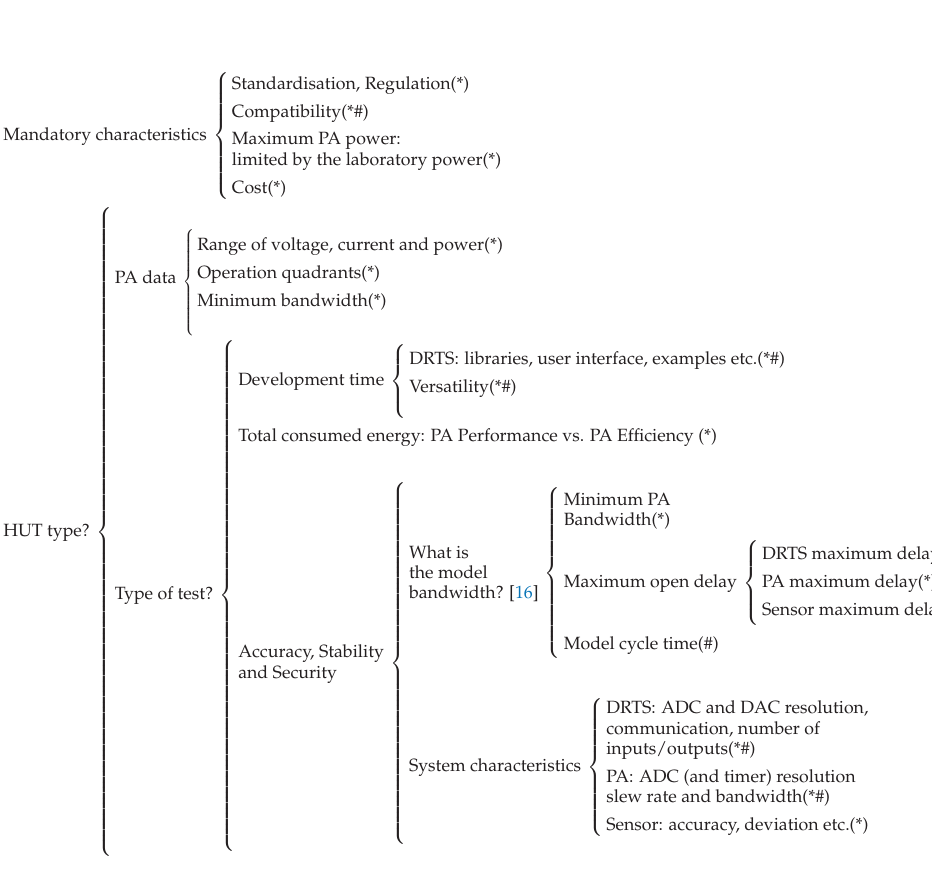
Figure 3. PHIL system guide scheme selection (“*” Manufacturer information; “#” State-of-the-art